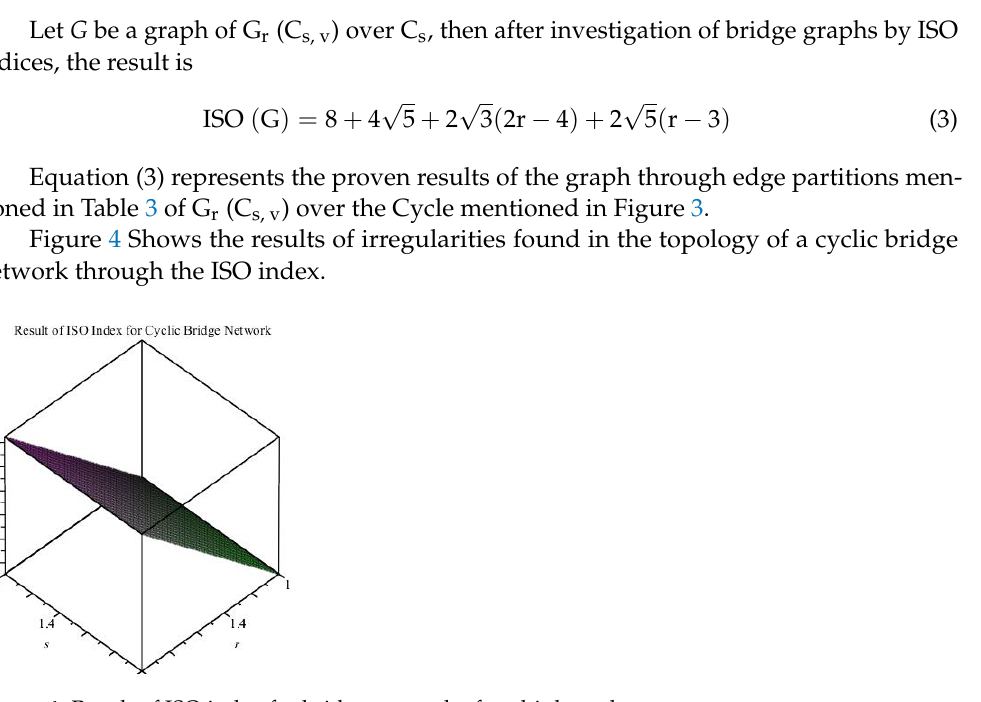
Figure 4. Result of ISO index for bridge network of multiple cycles.